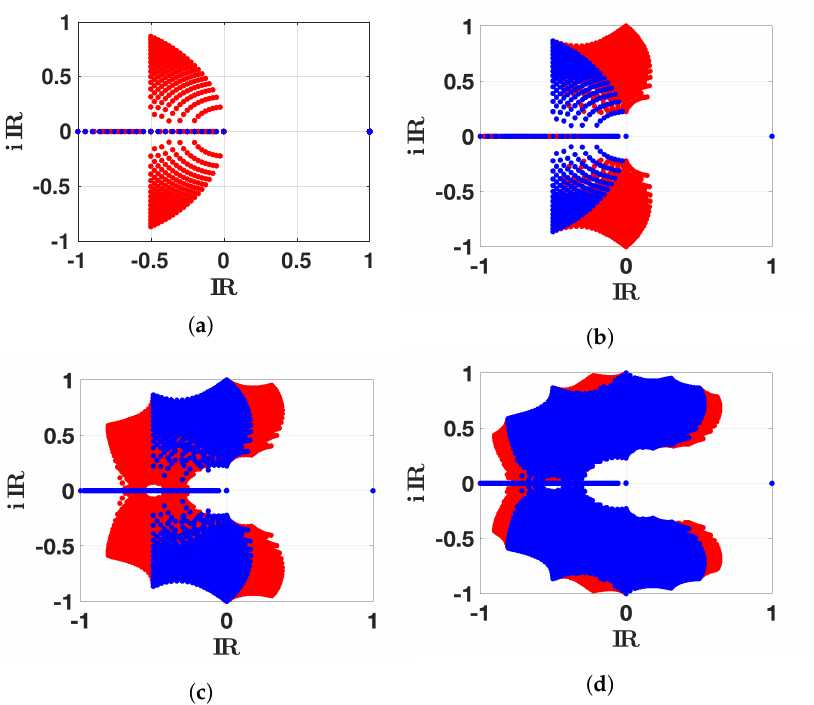
Figure A1. We plot all the spectrum’s locations for Markovian Leslie matrices on a mesh whenever n = 3 in ( a ), n = 4 in ( b ), n = 5 in ( c ), and n = 7 in ( d ). Here the dominant eigenvalue is always 1, and we can see the corresponding isolated blue dot. The blue region corresponds to the spectrum of Markovian Leslie matrices whenever R 0 ( n ) = 0. The red region corresponds to the spectrum of Markovian Leslie matrices whenever R 0 ( n ) >